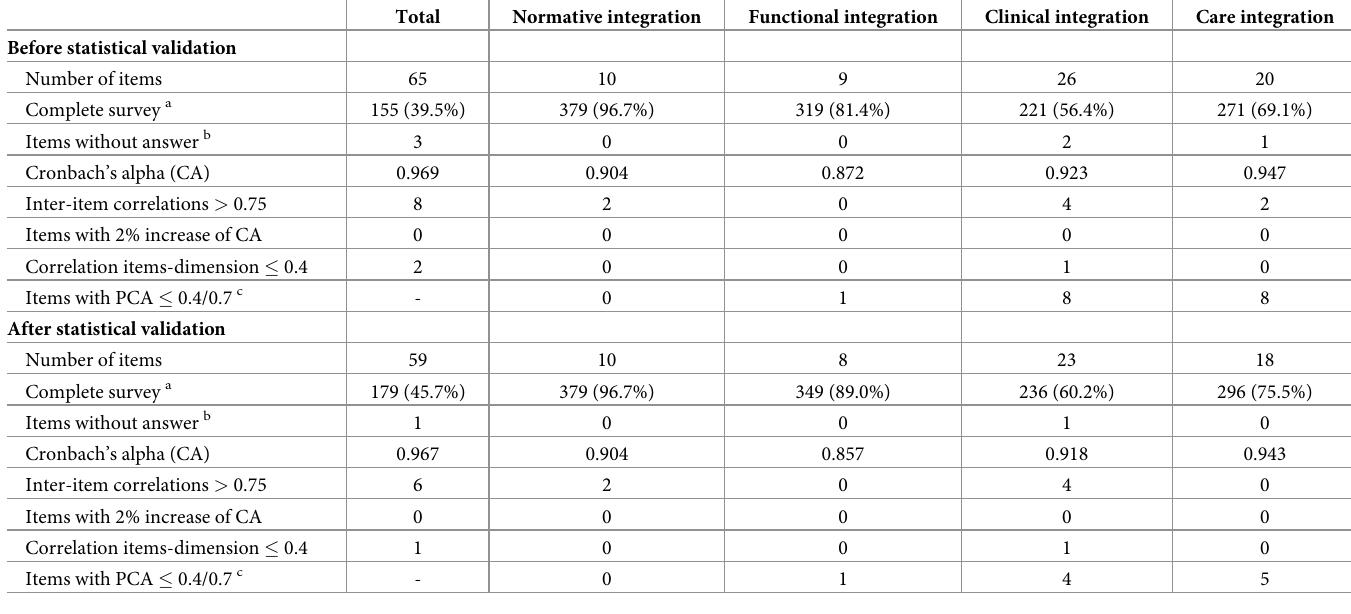
Table 2. Descriptive statistics before and after validation of the questionnaire (n =